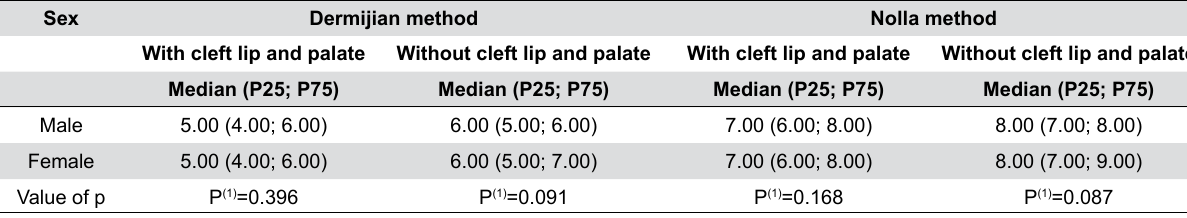
Table 5- Analysis of permanent second molar development according to sex using the Mann-Whitney's